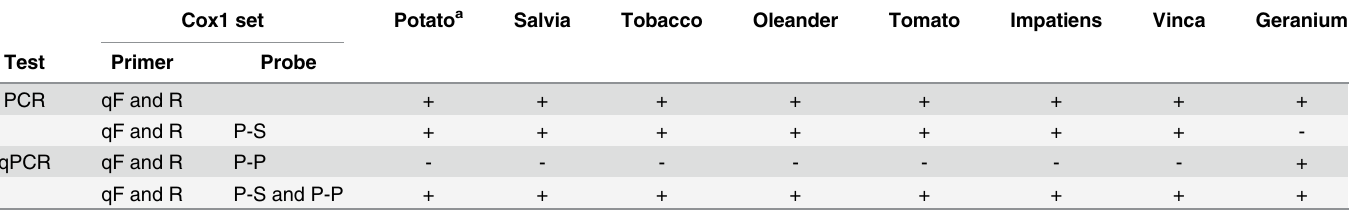
Table 3. Test of our Cox1 primers and probes on different plant species by PCR and qPCR assays.